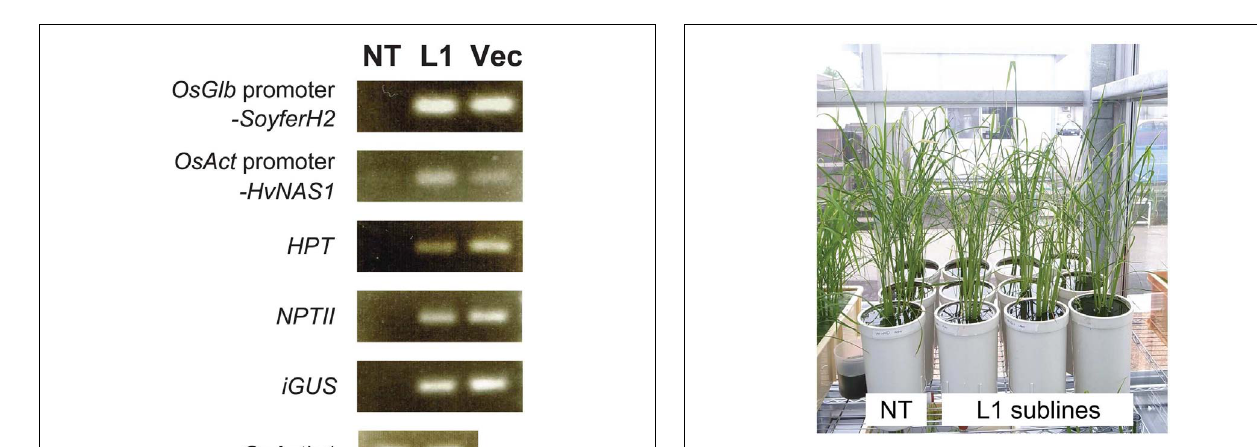
FIGURE 8 | Greenhouse-grownT 1 plants . Photograph was taken during tillering stage at 30days after transplanting. NT, non-transgenic Paw San Yin. L1 sublines, Paw SanYin-Fer-NAS-YSL2 transgenic line 1